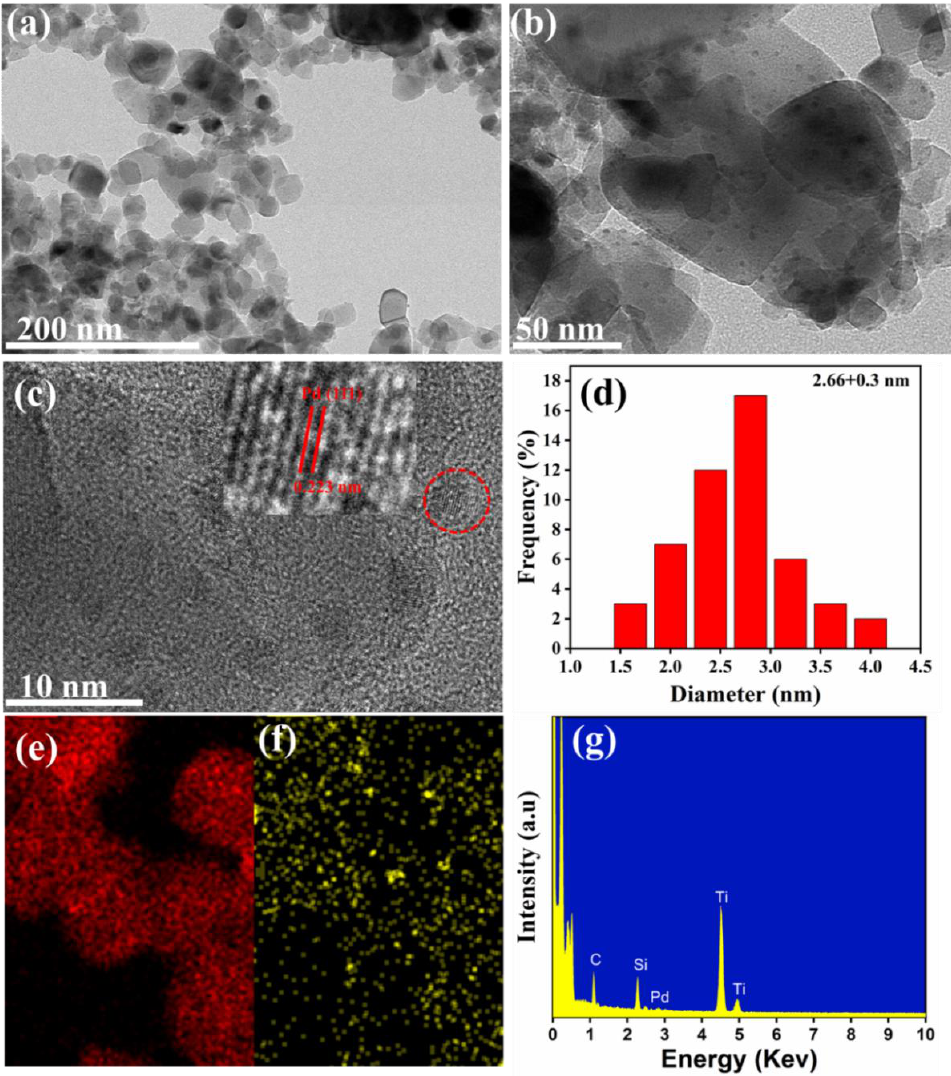
Figure 3. TEM images of TiO 2 ( a ) and Pd/TiO 2 ( b ); ( c ) HRTEM image of Pd/TiO 2 ; ( d )the particle size distribution of Pd/TiO 2 ; ( e ), ( f ) EDX elemental mapping images of Pd/TiO 2 and the corresponding element distribution of ( e ) Titanium, ( f ) palladium; ( g ) EDX diagram of Pd/TiO 2 .